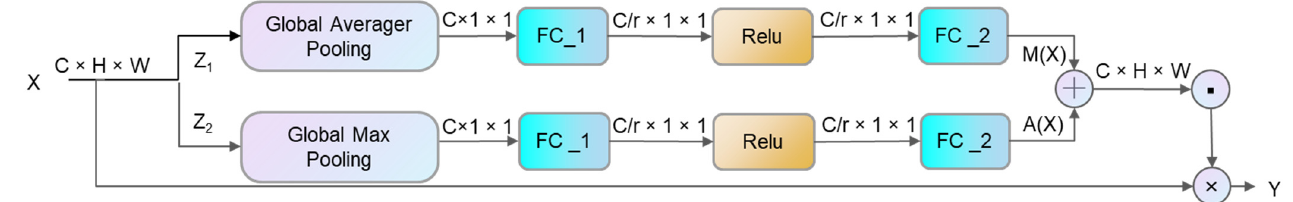
Figure 7. The process of weight fusion (the input vector X is subjected to global max pooling and global average pooling, respectively, and then added through the FC_1, Relu, and FC_2 layers, respectively. The result is cross-multiplied with the original input X to obtain the final output vector Y).